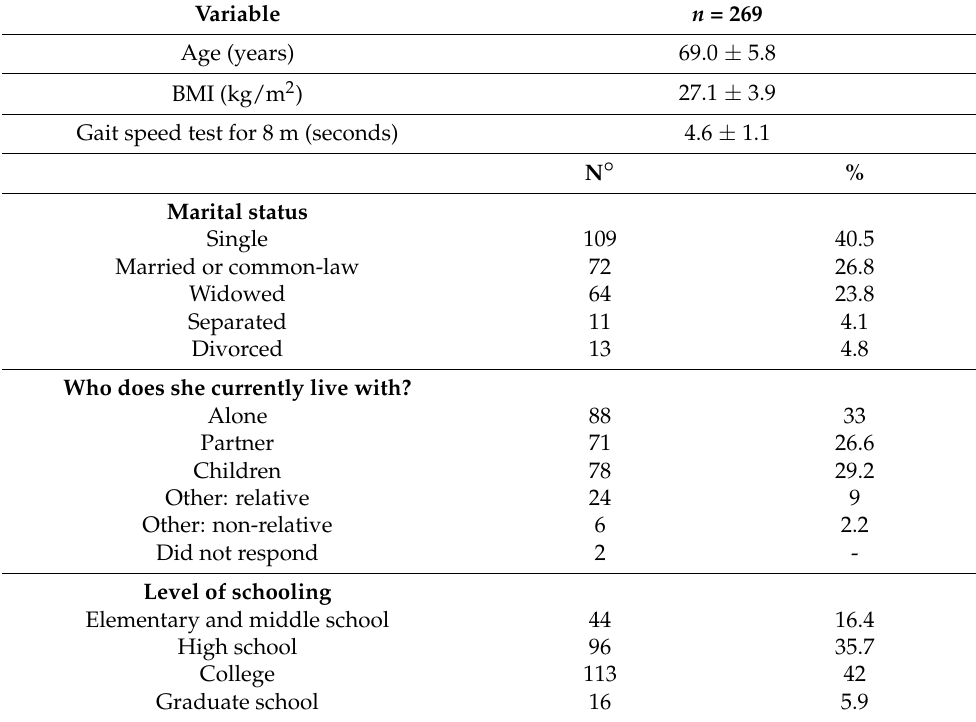
Table 1. Characteristics of functionally independent study participants aged 60